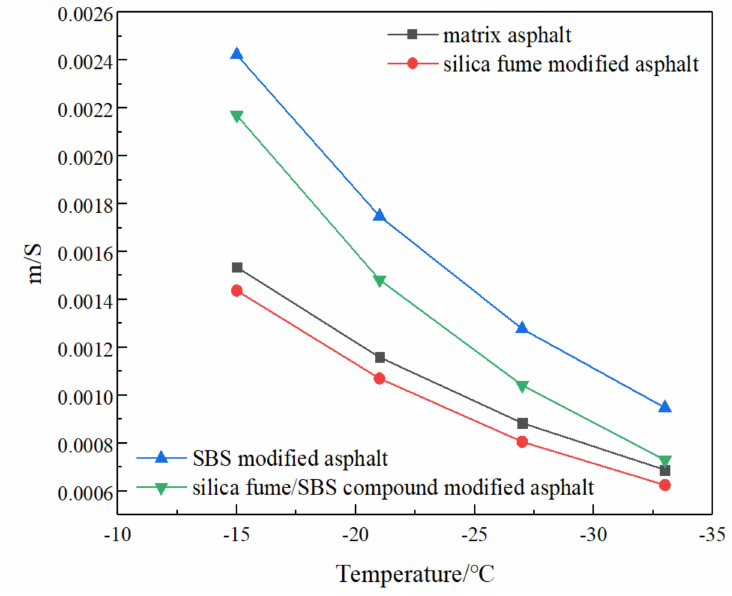
Figure 8. Curves of m / S of four kinds of asphalt with